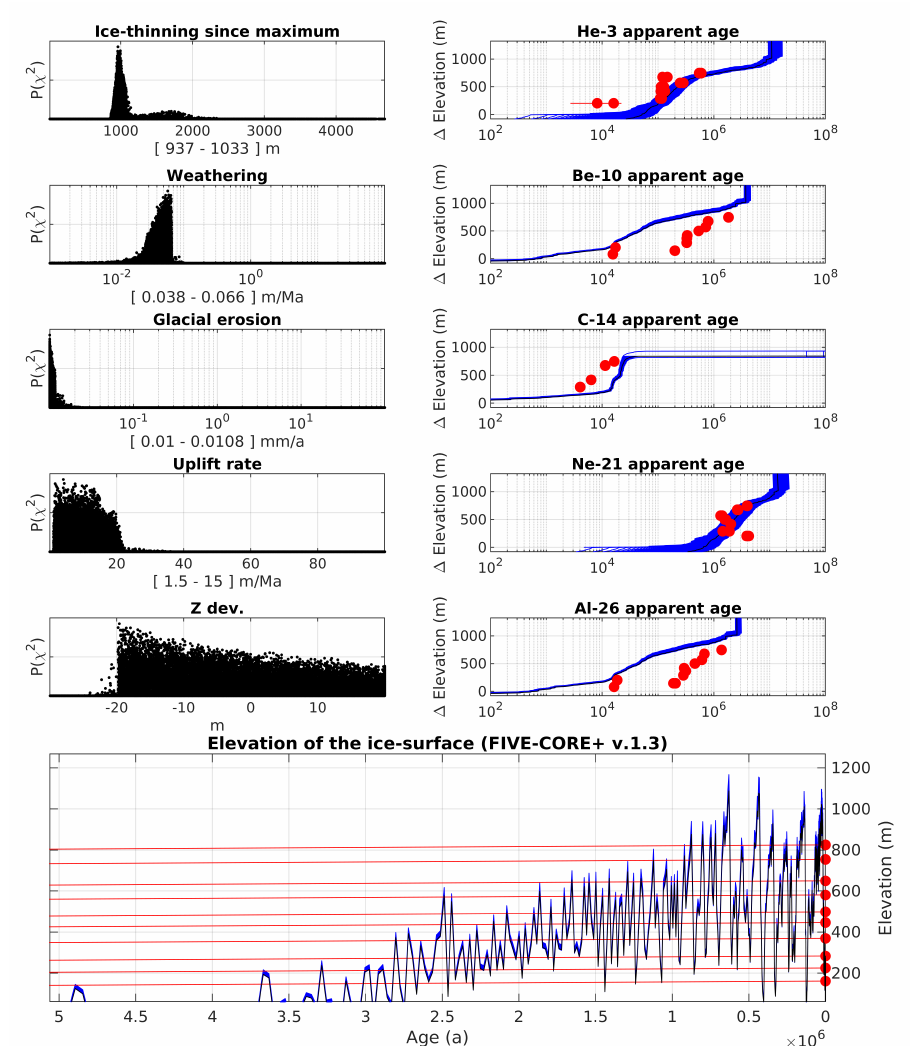
Figure 6. Full graphical output of the NUNAIT calculator for Mt. Hope data set. Left graphs show the probability distribution of the fitting parameters. Right graphs show the best model, the models fitting the data within 1 σ , and the sample exposure ages in black, blue, and red, respectively. The best fit yielded a reduced chi-squared value of 78.7. The bottom graph shows the evolution of the ice surface and the position of the samples according to the model best fit and one sigma